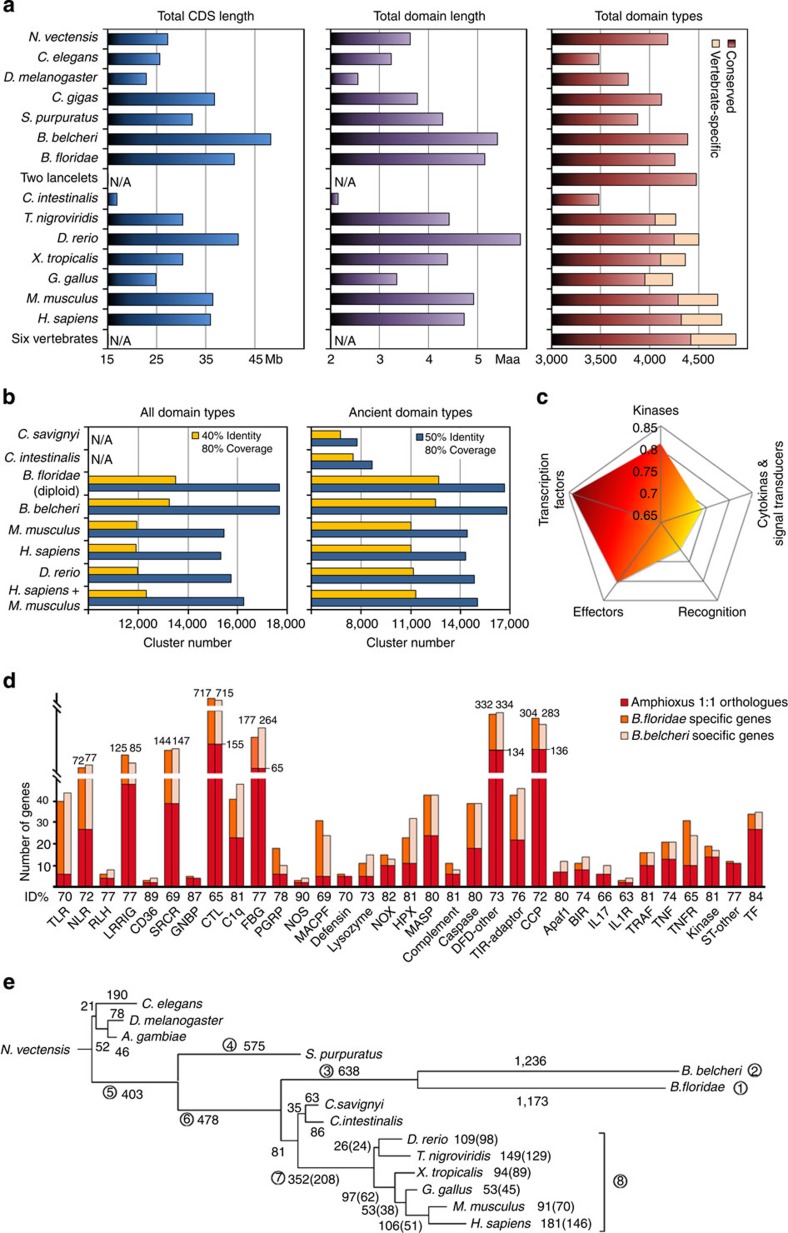
Comparative analysis of protein diversity.(a) Comparison of total CDS length, total Pfam-A domain length and total Pfam-A domain type numbers from the sequenced genomes of a variety of species. All known spliced isoforms were included. (b) Comparison of domain sequence diversity between lancelets and vertebrates. The diversity was directly measured using the numbers of sequence clusters created using BLASTCLUST. All (Pfam-A) domain types and ancient domain types (that is, non-vertebrate-specific domain types) were analysed separately. (b) The increasing trend of average sequence identity of proteins in five sequential phases of the immune response, from recognition to transcription factors. (d) The expansion and diversification pattern of the immune and stress protein gene repertoire. Average protein identity and the number of 1:1 orthologue proteins versus species-specific proteins are shown. (e) The number of novel domain pairs gained by different lineages. Branch length is proportional to the number of novel domain pairs. Numbers outside and within parentheses represent all novel domain pairs and the novel domain pairs containing no vertebrate-specific domains, respectively. Numbers in circles represent the eight important lineages: B. floridae, B. belcheri, amphioxus ancestor, S. purpuratus, deuterostome ancestor, chordate ancestor, vertebrate ancestor and all six vertebrates. More information is provided in Supplementary Notes 11 and 12.